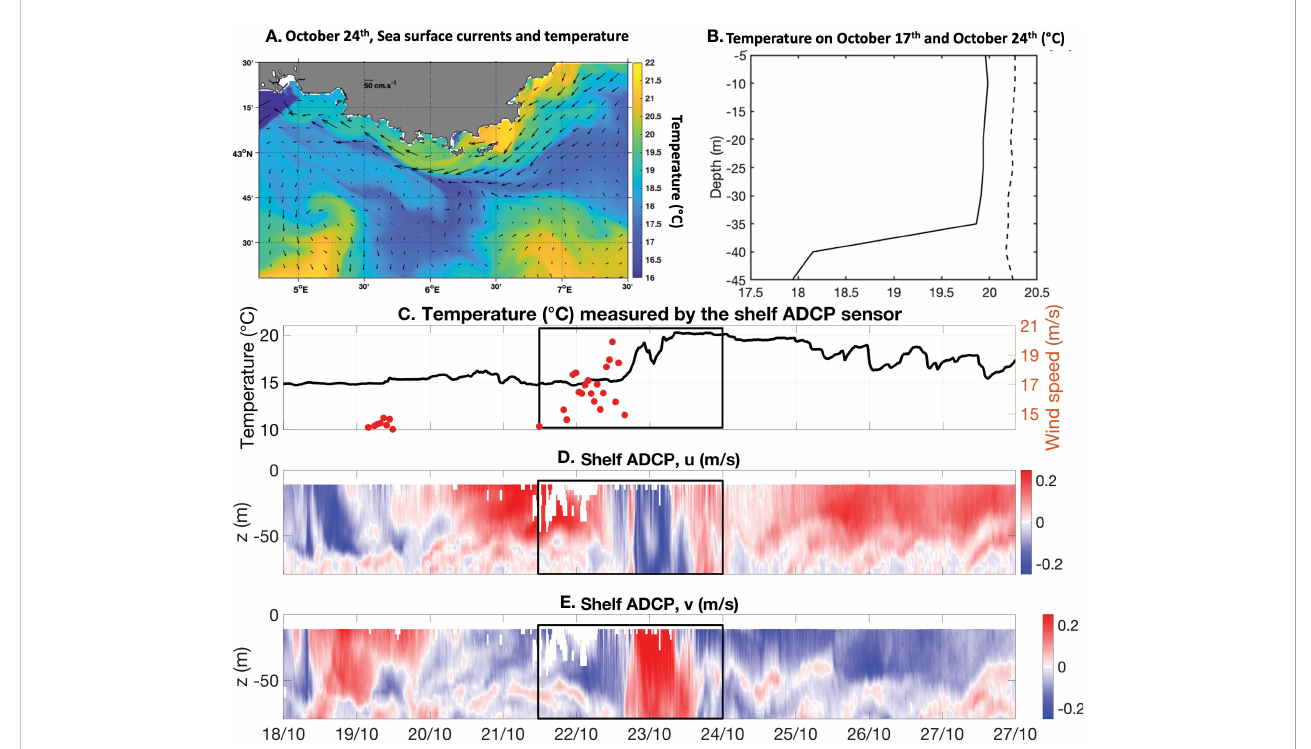
FIGURE 6 (A) Sea surface velocity currents (arrows) and temperature (°C, colors) estimated by the MARS3D MENOR 1200 model on October 24 th 2019 at 12:00. (B) Temperature pro fi les measured by temperature sensors at the T-MedNet Cassidaigne station on October 17 th at 12:00 (continuous line) before a NC intrusion over the Gulf of Lions and on October 24 th at 12:00 (dashed line) during a NC intrusion over the Gulf of Lions. (C) Temperature (black line, °C) measured by the shelf ADCP at 86 m depth and wind speed (red dots) estimated by the AROME meteorological model. An easterly storm of more